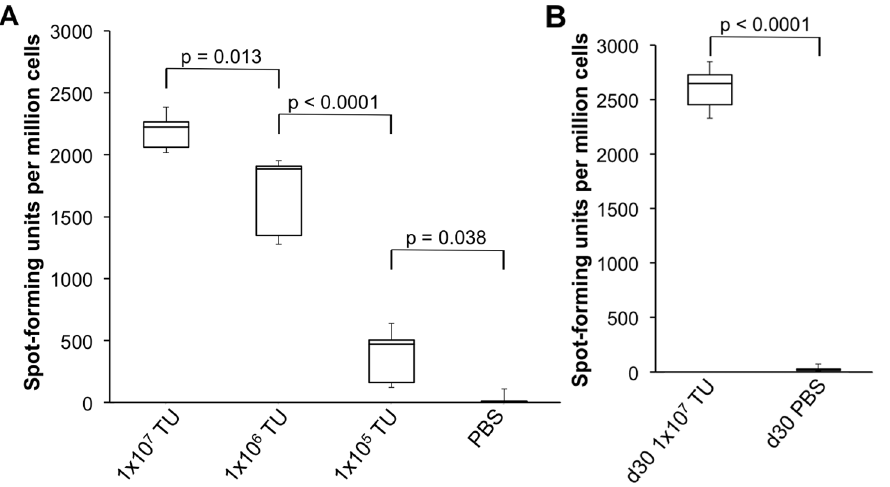
Figure 3. IDLV generate dose-responsive and antigen-specific T cell responses in mice. Groups of BALB/c mice (n=3) were immunized i.m. with varying doses (TU/mouse) of IDLV-GFP, as indicated. Splenocytes were assayed on day 10 ( A ) or day 30 ( B ) post-immunization by ELISPOT for IFN- c responses to an H-2k d -restricted 9-mer GFP peptide, or to an unrelated peptide (not shown). Mice injected with PBS served as a negative control. The Kruskal-Wallis test was used to compare GFP levels between the dosing groups (overall p-value of 0.006). P-values from pairwise dose group comparisons based on the ANOVA test are shown.